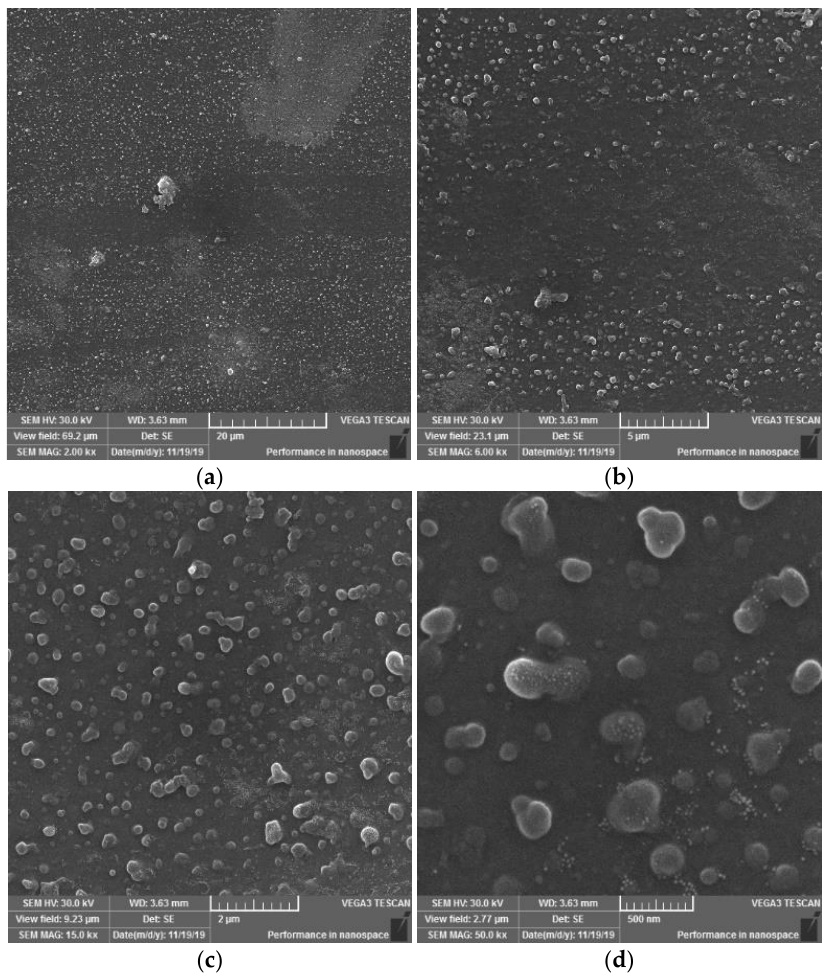
Figure 13. SEM morphology of the surface of plasma modified PVC exposure type II. Observed magnifications: 2000× ( a ), 6000× ( b ), 15,000× ( c ), 50,000× ( d ).